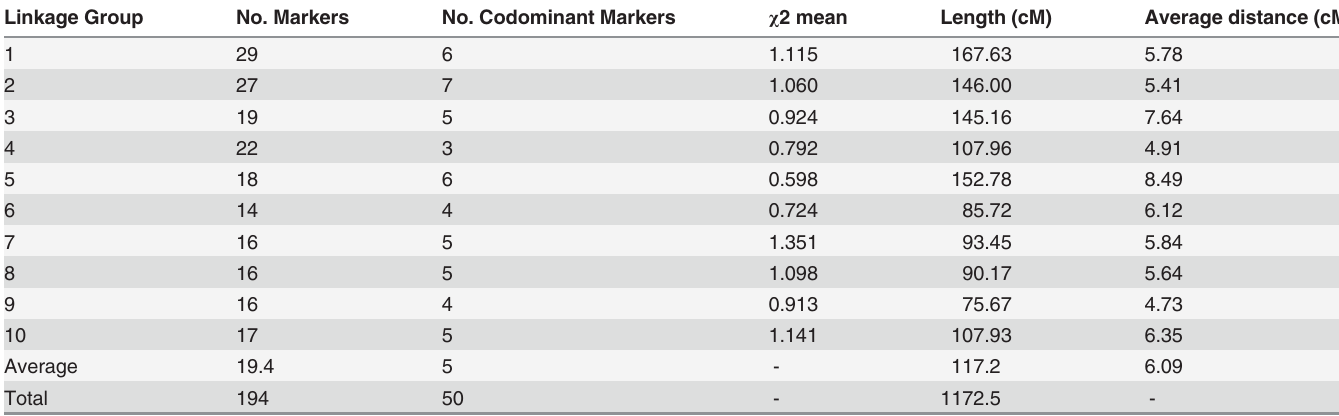
Table 3. Refined genetic linkage map of the maize population F 2 (PB260xPB266) (used for QTL mapping). Linkage